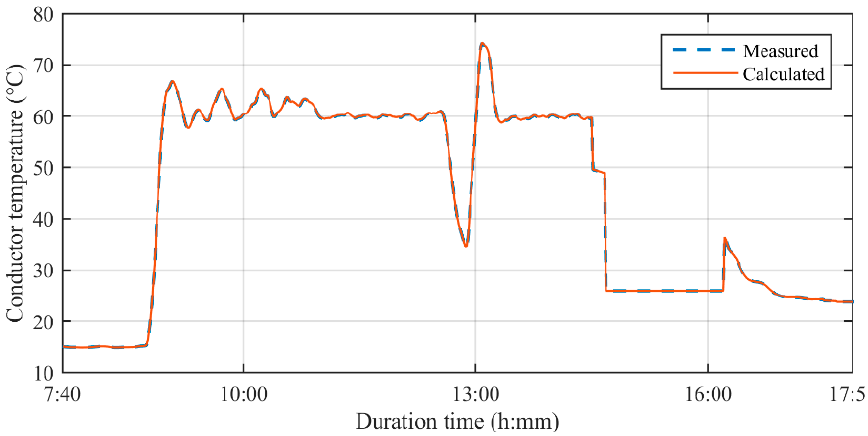
Figure 10. Measured and calculated conductor temperature.